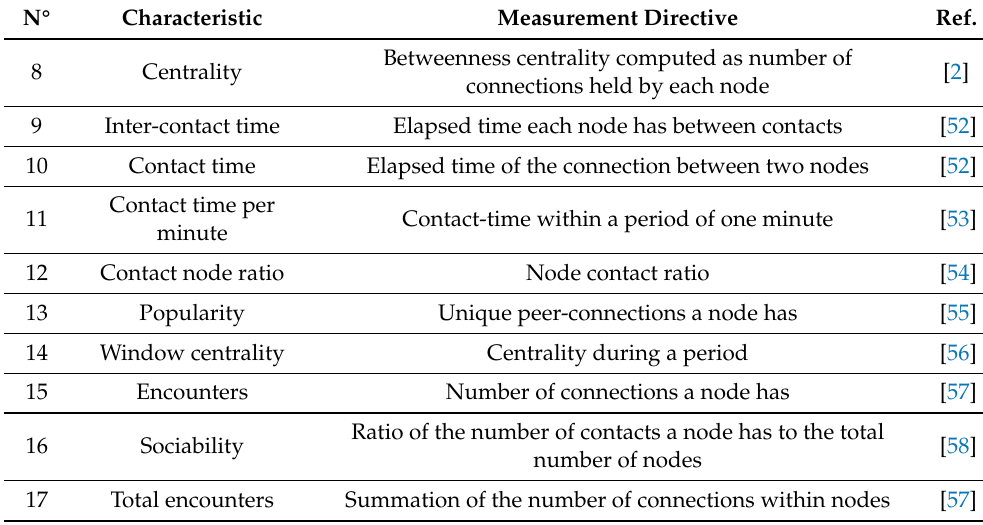
Table 2. Indirect scenario characteristics measurement directives with references.